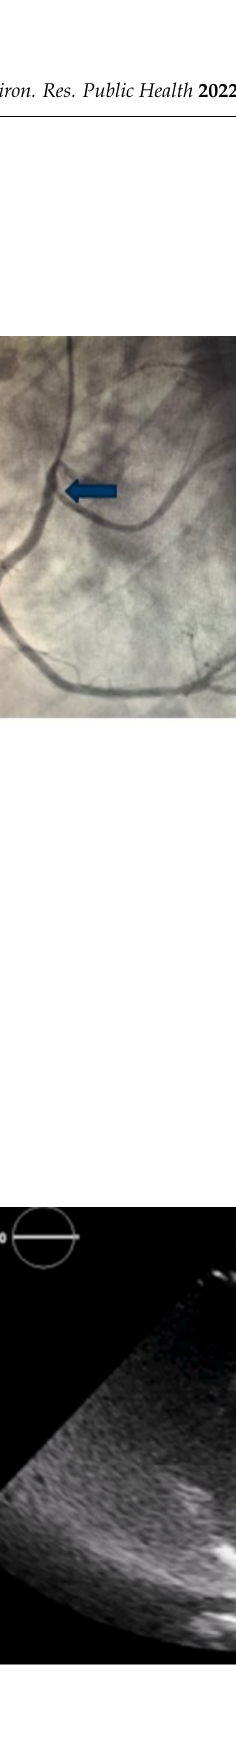
Figure 3. EKG on 3rd day after reperfusion documented QS complexes in the anterior leads and diffuse ventricular repolarization abnormalities, with preserved atrio-ventricular and intra-ventric- ular conduction. Cardiac MRI documented dilated LV with ejection fraction (EF) 34%, anterior and antero-septal wall akinesis (associated with increased T1 mapping values and areas of late gadolinium enhancement or LGE after contrast injection, compatible with ischemic pat- tern), infero-lateral wall hypokinesia and LV free wall marked hypertrabecularization with a telediastolic NC/C ratio of 5 in long-axis view (Figure 4A,B).